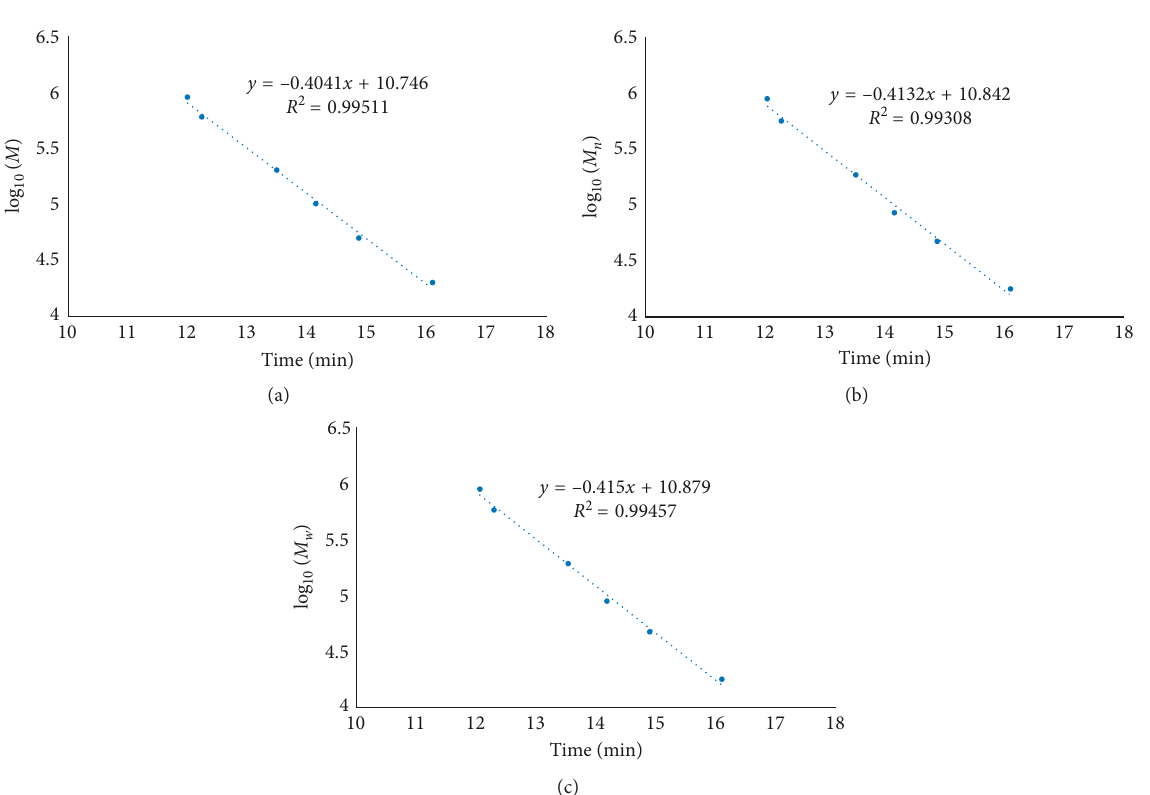
n ) of polystyrene;